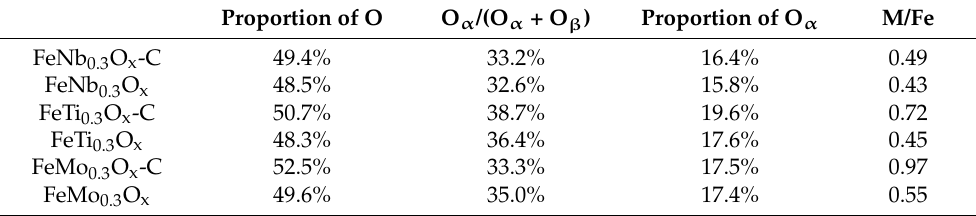
Table 4. Surface components of all the FeM 0.3 O x -C and FeM 0.3 O x (M = Nb, Ti, Mo) samples from XPS results.